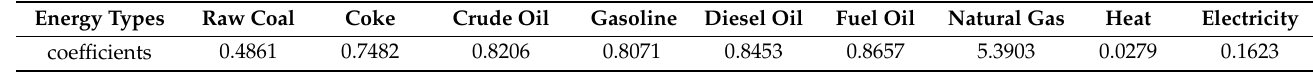
Table 1. Carbon emission coefficients of various energy